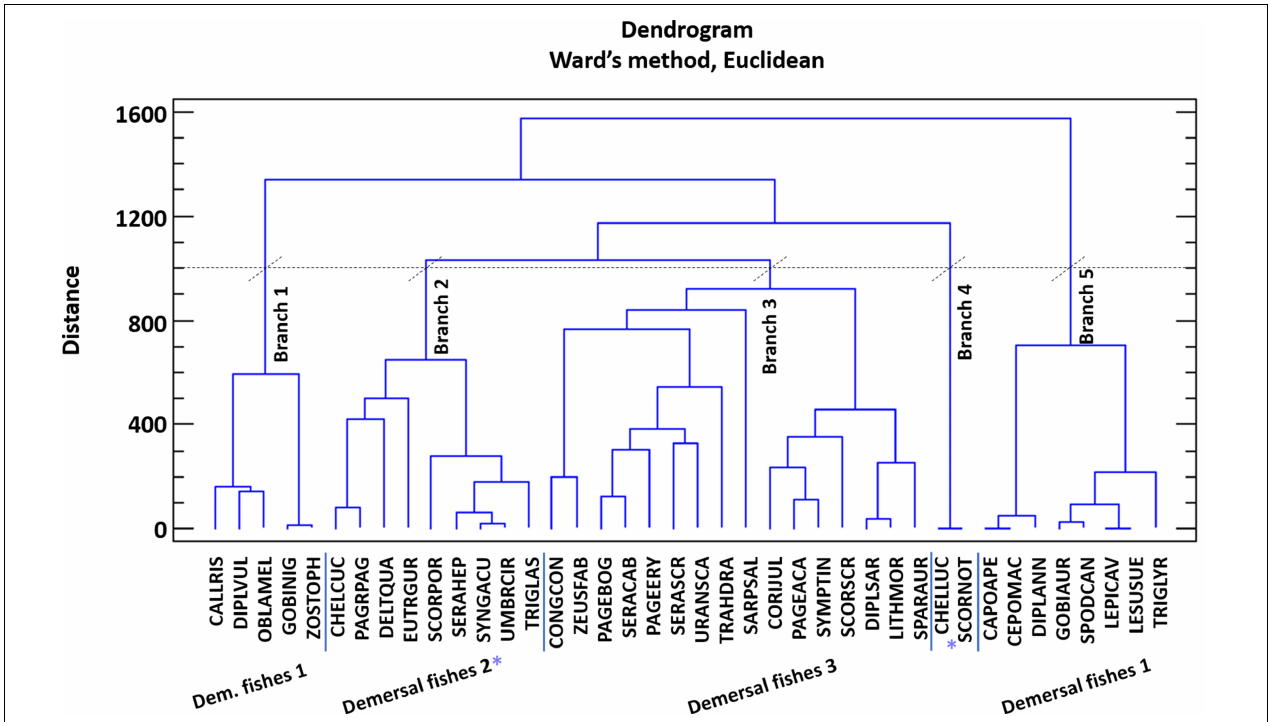
FIGURE 2 | Cluster analysis of the diet composition of 40 fish species for their categorization in functional groups. Species codes are given in Supplementary Table A2 .